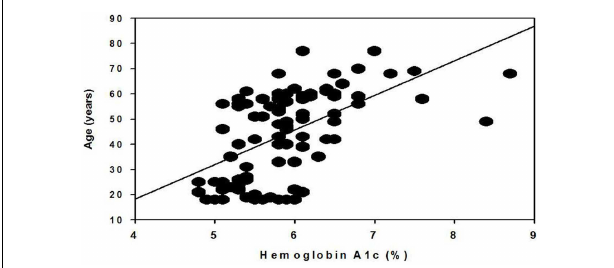
FIGURE 1 | Correlation of hemoglobinA1c and age . Data include both male and female participants from a rural North Carolina cohort of the African-American Calcium Homeostasis and Metabolic Problems Study (Mildred A. Pointer, PI).